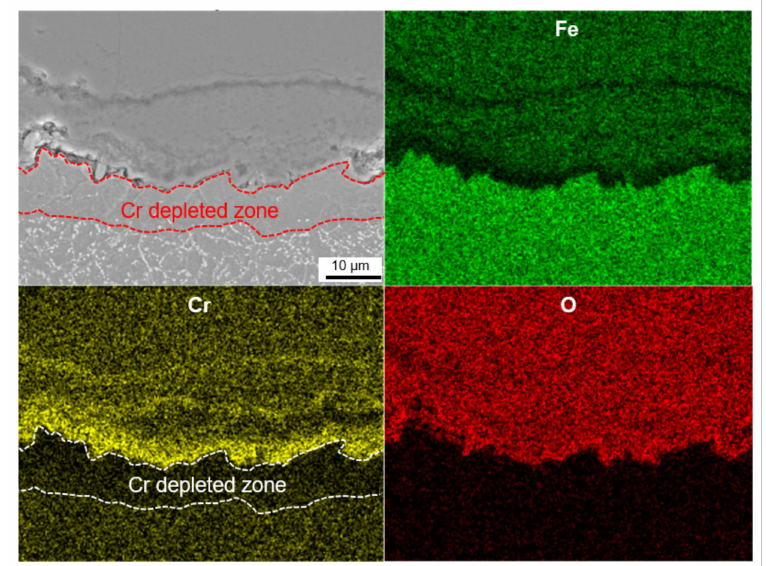
Figure 8. Cross-sectional SEM images of oxidation scale of SP-treated specimen after 600 h steam